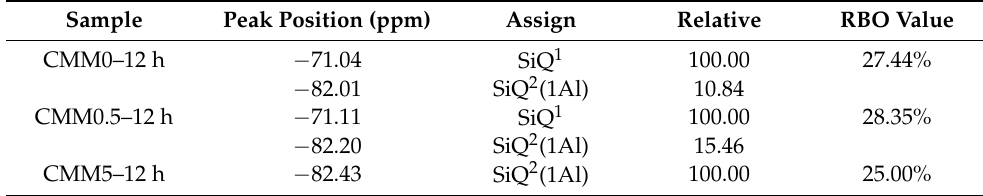
Table 5. The RBO values of CMM0, CMM0.5 and CMM5 samples autoclaved for 12 h.